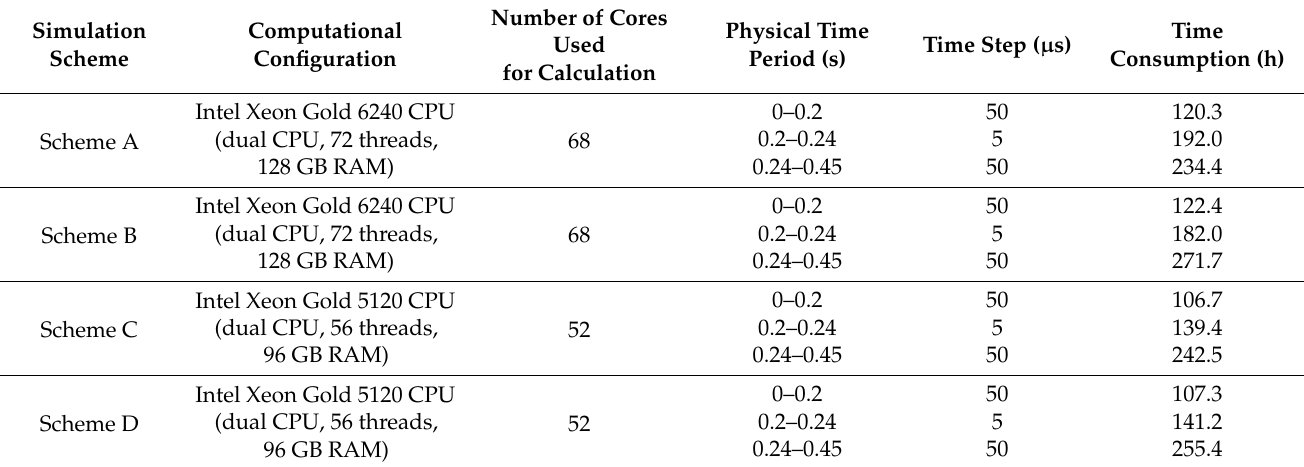
Table 3. Calculation information for different simulation